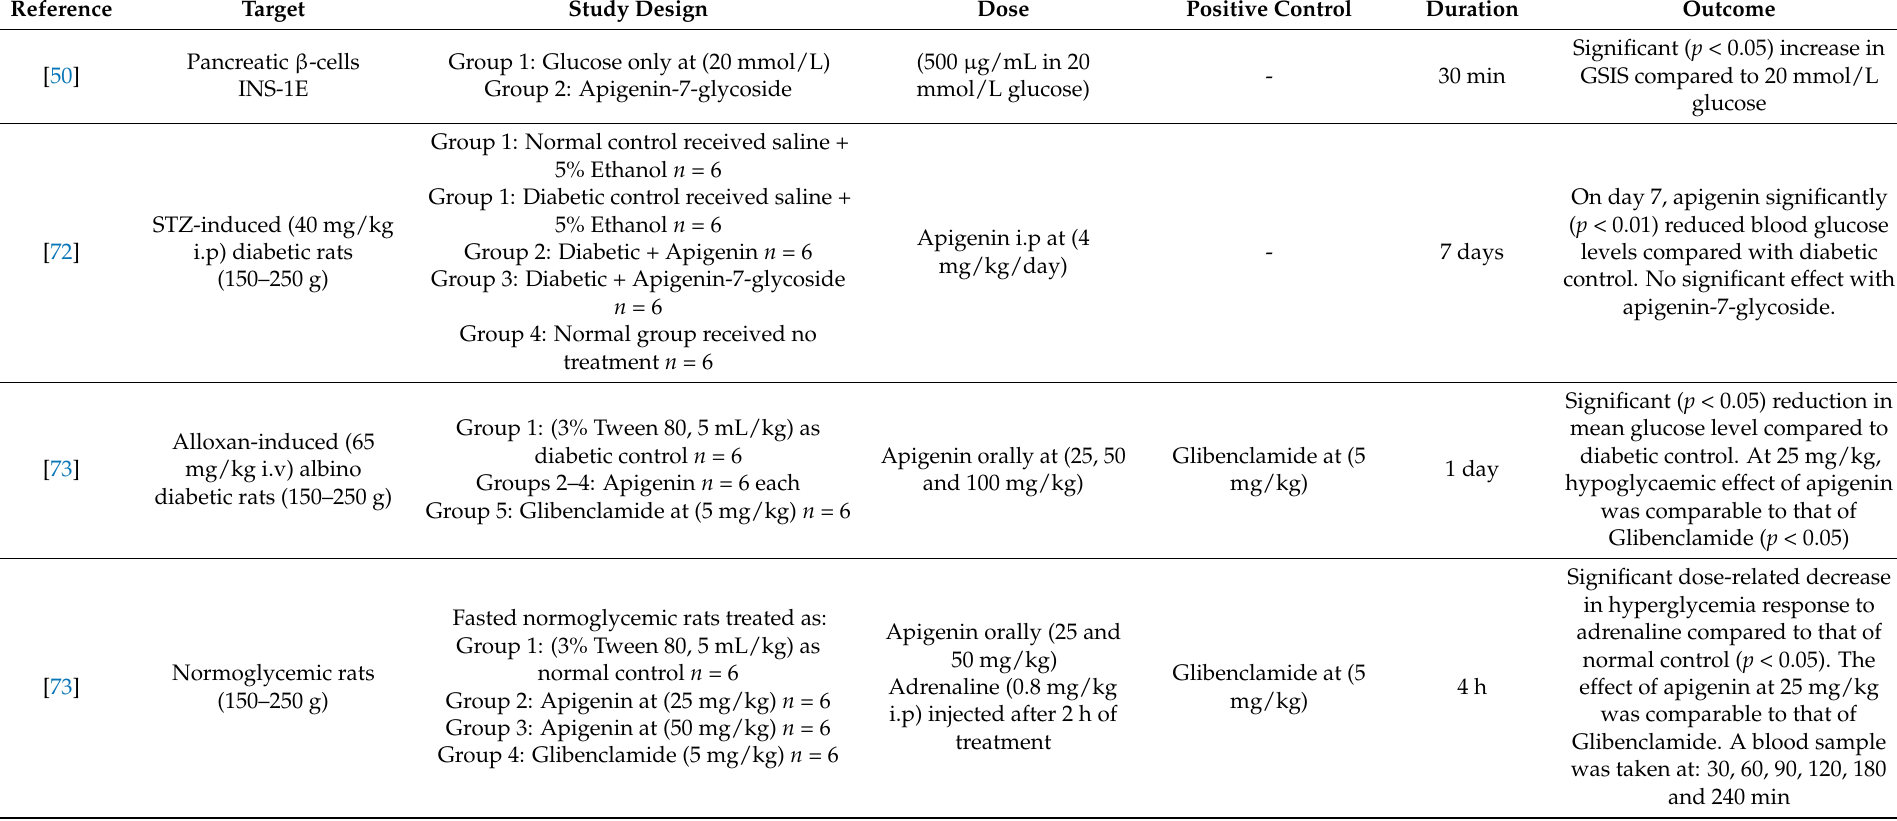
Table 3. Apigenin potential in lowering blood glucose